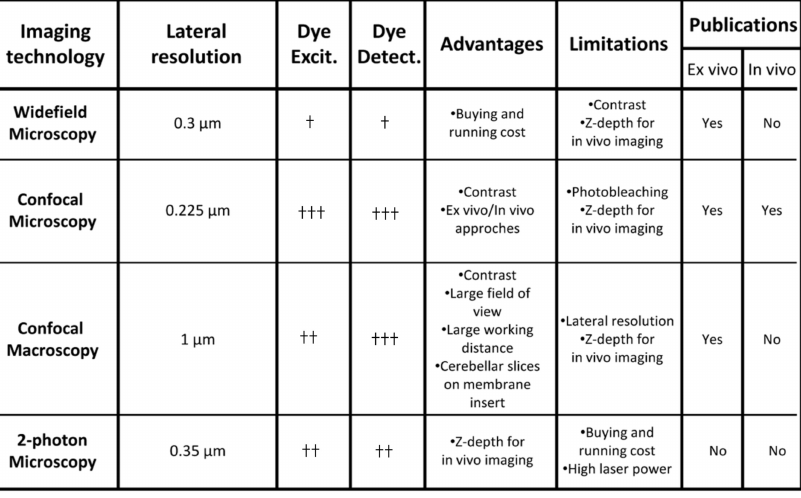
Figure 3. Comparative analysis of imaging technologies used for ex vivo/in vivo interneuron migration studies in the postnatal cerebellum. †, weakly efficient; ††, moderately efficient; †††, highly